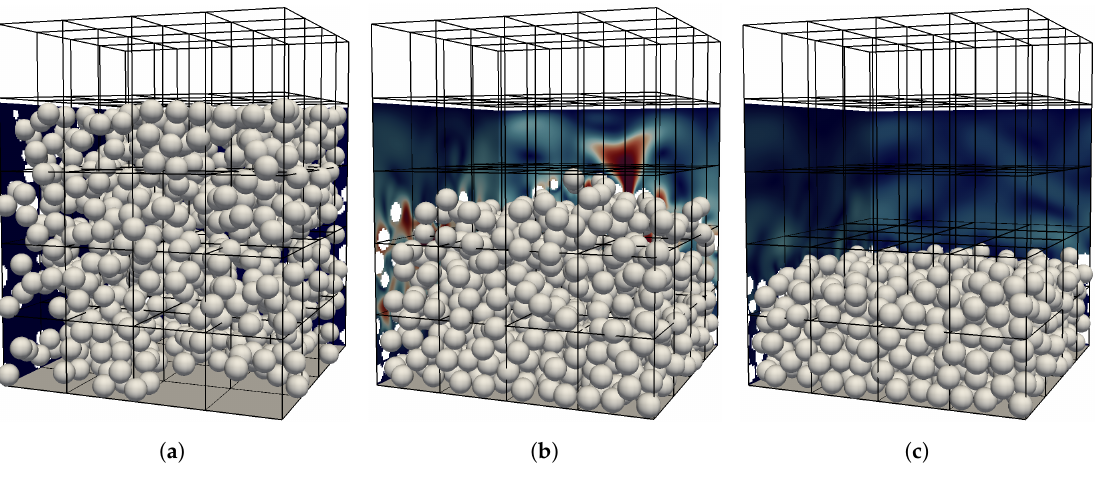
Figure 5. Workload evaluation simulation with b s / ∆ x = 32 and D / ∆ x = 10. Black boxes show the 4 × 4 × 5 blocks used for domain partitioning. The magnitude of the fluid velocity is shown in two slices at the back of the domain. ( a ) Initially random particle distribution ( t ∗ = 0). ( b ) Ongoing settling ( t ∗ = 1.3). ( c ) Final, completely settled state ( t ∗ =